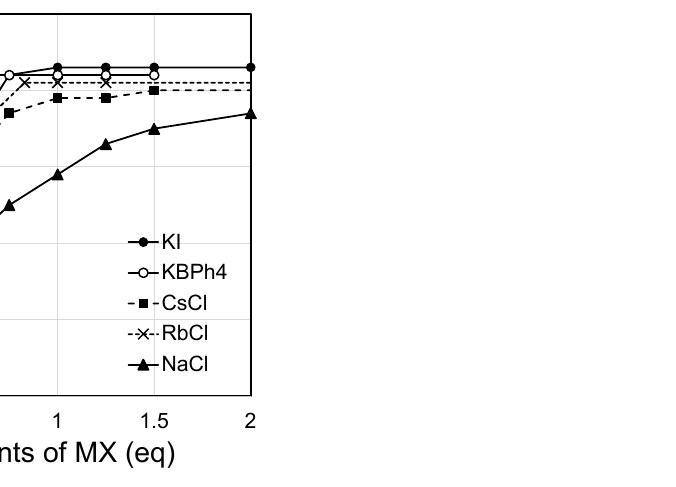
Figure 4. Peak separation widths for H b and H c protons of 3 [ ∆ (H b − H c )] in the 1 H NMR spectra as a function of the amounts of alkali metal salt MX added. The spectra were measured in CD 3 OD.